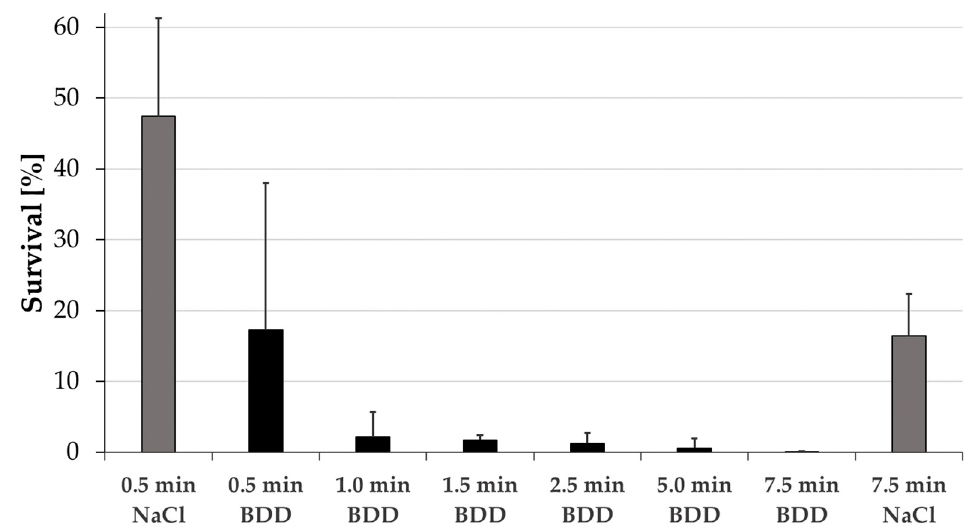
Figure 3. Disinfection of root canals. Percentage of E. faecalis surviving root canal irrigation with saline (grey) and electrochemical disinfection (black) for treatment times up to 7.5 min. CFU before treatment were set to 100%. All experiments were carried out in quadruplicate (independent biological replicates) and standard deviations are shown.